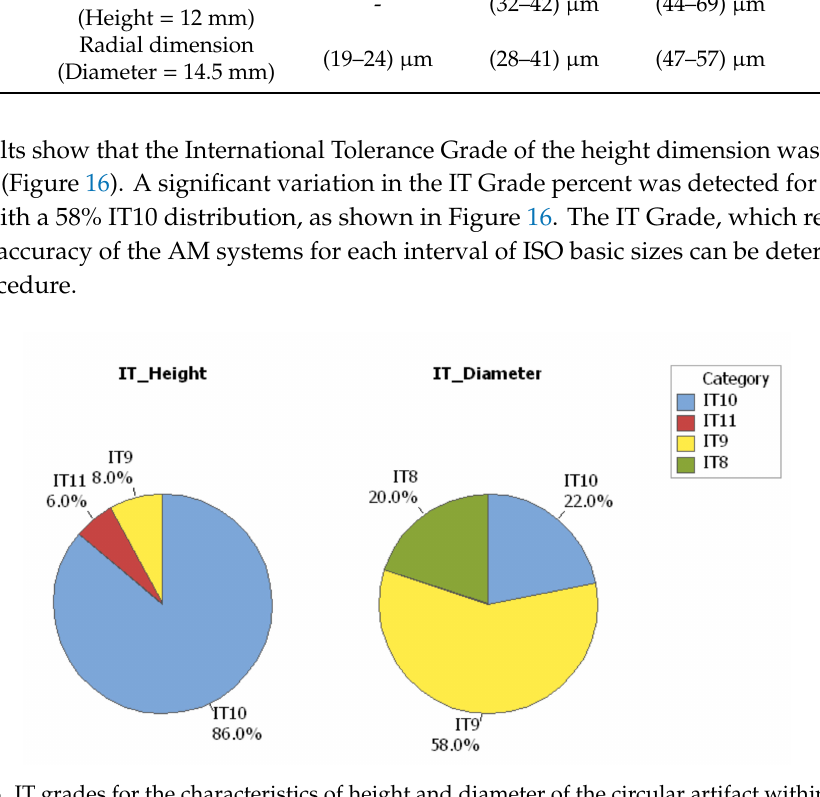
Figure 16. IT grades for the characteristics of height and diameter of the circular artifact within the size range (10–18